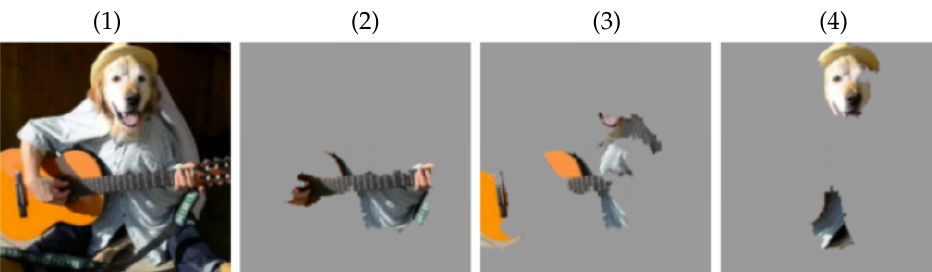
Figure 6. Reference [7] presented Local Interpretable Model-agnostic Explanations (LIMEs), which can explain the predictions of any agnostic black box classifier and any data. Here, the superpixels, which are areas of an input image, are highlighted that are most responsible for the top three image classification predictions: (1) original image, (2) explaining electric guitar, (3) explaining acoustic guitar, and (4) explaining